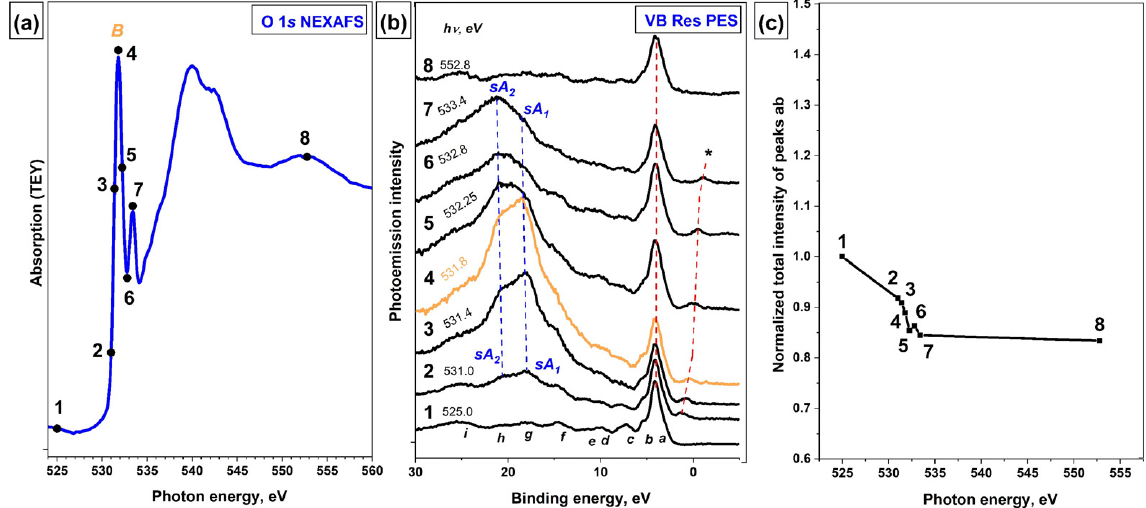
Figure 6. ( a ) O 1s NEXAFS spectrum, the photon energies h ν used to excite the VB PE spectra are marked with numbered dots; ( b ) a series of resonant VB PE spectra of the [Ni(Salen)] complex; and ( c ) the total intensity of the a-b bands depending on the energy of exciting photons in the vicinity of the O 1s absorption edge ( h ν = 525–552.8 eV) of the [Ni(Salen)] complex. In ( b ), the O 1s PE line resulting from the absorption of synchrotron radiation reflected by the diffraction grating in the second order is marked with an asterisk (*). The total intensity of the PE bands a-b at different photon energies was normalized to their intensity at h ν = 525 eV (non-resonant excitation).